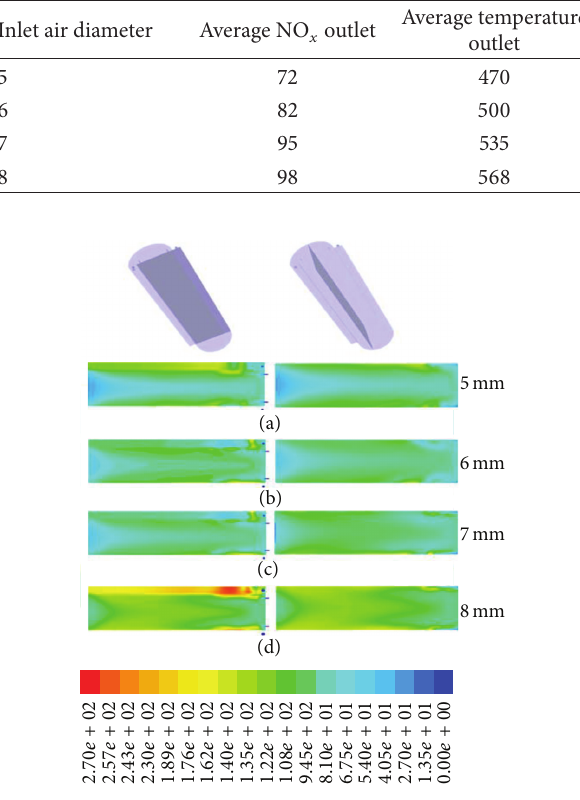
Figure 8: NO 𝑥 emissions (ppm) contour for different air diameters: (a) 𝑑 = 5 mm, (b) 𝑑 = 6mm, (c) 𝑑 = 7 mm, and (d) 𝑑 = 8 mm.